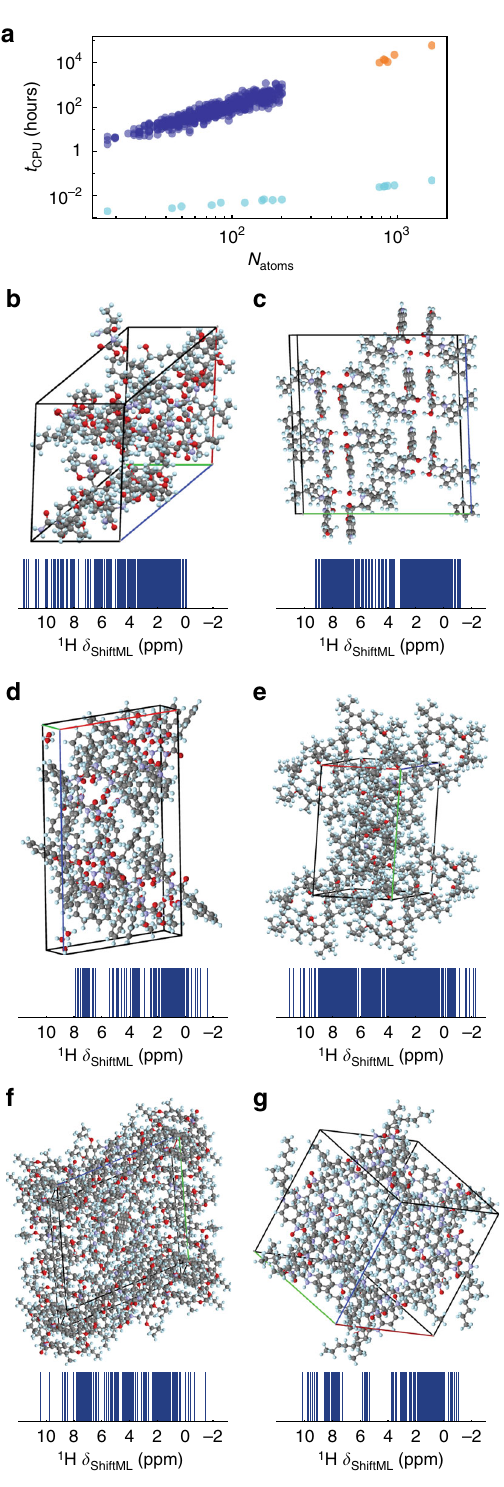
Fig. 7 Chemical shift calculation times and large structures. a DFT GIPAW calculation time (blue) and ShiftML prediction time (turquoise) for different system sizes. The GIPAW DFT calculation time for the six large structures (orange) is estimated from a cubic dependence on the number of valence electrons in the structure (see Supplementary Methods). b - g 3D-shemes and 1 H NMR spectra predicted with ShiftML, of the six large molecular crystals with CSD refcodes: b CAJVUH 69 , N atoms = 828, c RUKTOI 70 , = 768, d EMEMUE 71 , N = 860, e GOKXOV 72 , N = 945, N atoms atoms atoms f HEJBUW 73 , N atoms = 816, and g RAYFEF 74 , N atoms =